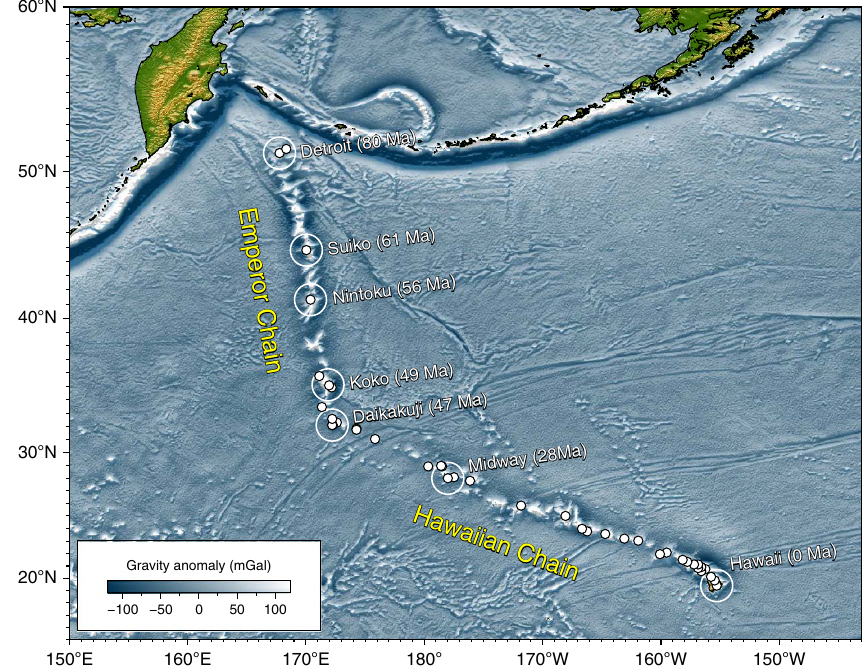
Figure 1 | Hawaiian-Emperor Chain. White dots are the locations of radiometrically dated seamounts, atolls and islands, based on compilations of Doubrovine et al. 28 and O’Connor et al. 40 . Features encircled with larger white circles are discussed in the text and Fig. 2. Marine gravity anomaly map is from Sandwell and Smith 48